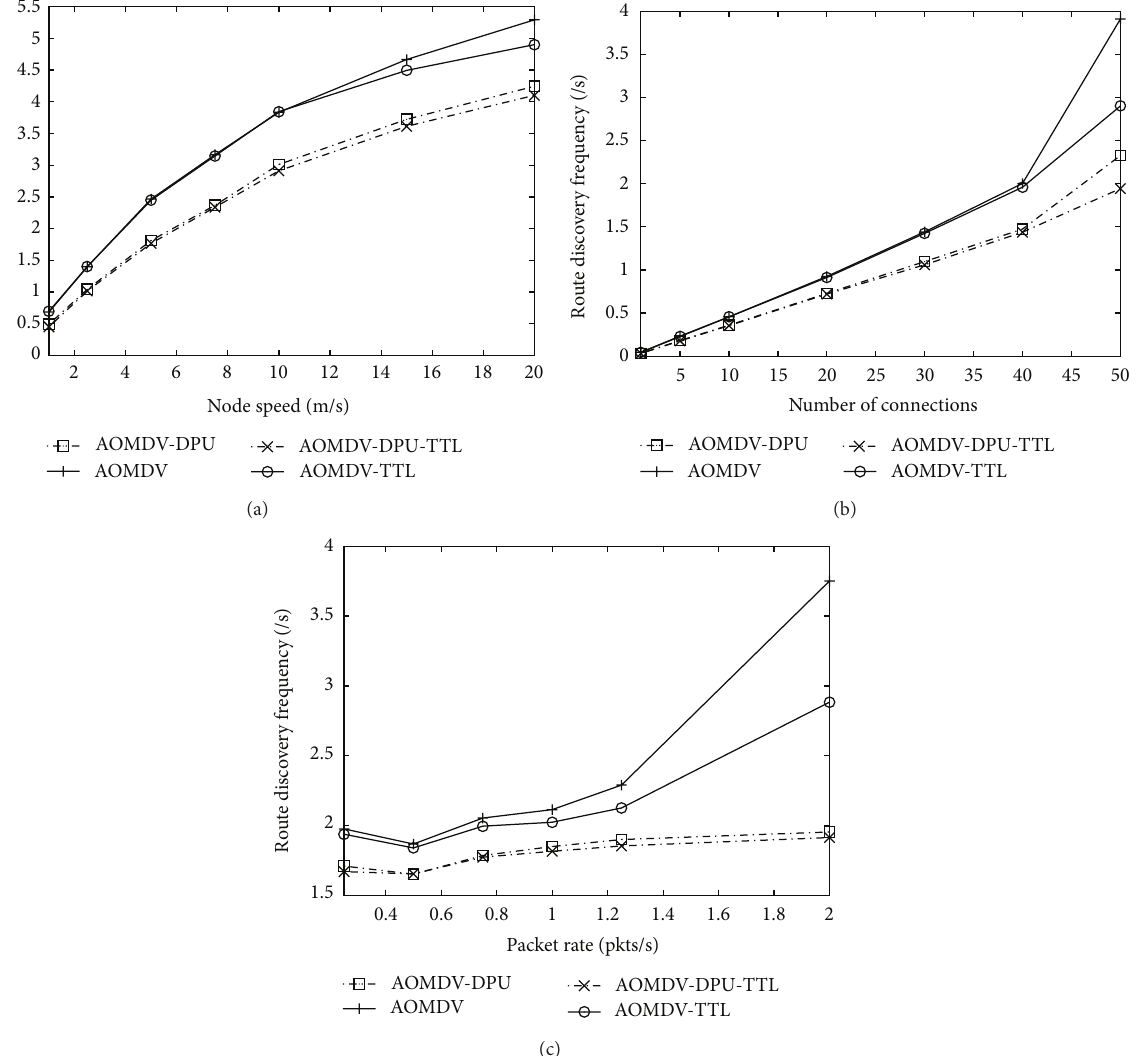
Figure 8: Route discovery frequency ( 𝐹 𝑅𝐷 ): (a) 𝐹 𝑅𝐷 versus node speed, (b) 𝐹 𝑅𝐷 versus number of connections, and (c) 𝐹 𝑅𝐷 versus packet generation